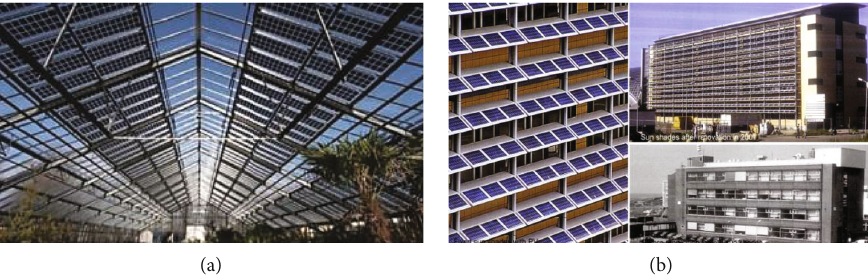
Figure 12: (a) Semitransparent PV modules integrated into a greenhouse roof. (b) Opaque and semitransparent PV used as shading in the Energy Research Centre in Northland Power [69,